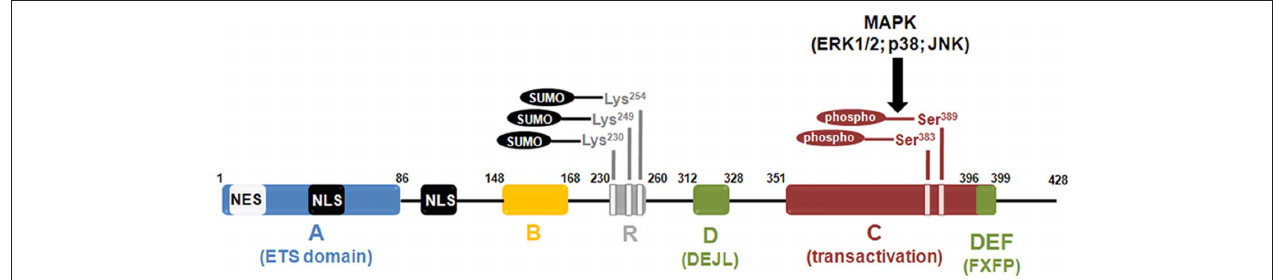
FiguRE 1 | Diagram illustrating functional domains and major post- translational modifications of the Elk-1 protein. The ETS domain (or A) domain lies within the n-terminus end of the protein and is responsible for Elk-1 binding to DNA. The B domain is involved in the binding of Elk-1 to a dimer of its cofactor, the SRF. The R domain is crucial for the repression of Elk-1 transcriptional activity. It contains the lysine residues that are susceptible to be SUMOylated, a post-translational event that reinforce the repression exerted by the R domain. The C (or transactivation) domain contains the amino acids that